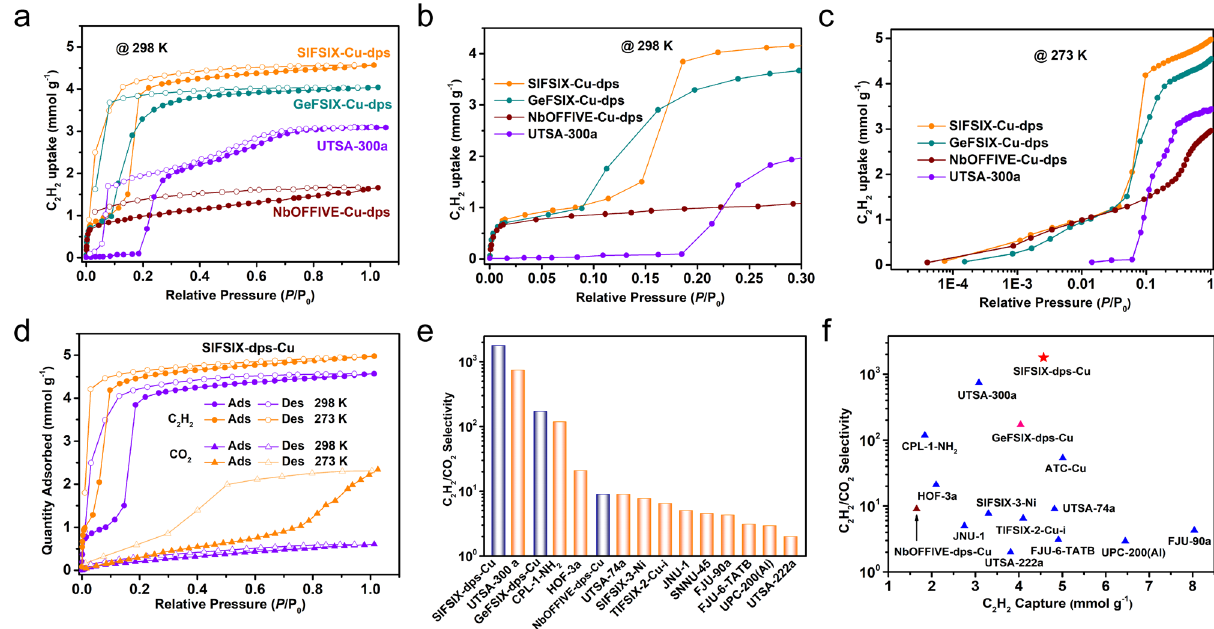
Fig. 2 C 2 H 2 and CO 2 sorption in four isoreticular MOFs. The C 2 H 2 sorption isotherms at a 0 – 1.0 bar and b 0 – 0.3 bar under 298 K. c The C 2 H 2 sorption isotherms at logarithmic 0.01 – 1.0 bar of SIFSIX-dps-Cu, GeFSIX-dps-Cu, NbOFFIVE-dps-Cu, and UTSA-300a at 273 K. d the C 2 H 2 and CO 2 adsorption isotherms of SIFSIX-dps-Cu at 273 and 298 K. e comparison of IAST selectivity of representative MOFs for 50/50 C 2 H 2 /CO 2 . f Comparison about C 2 H 2 / CO 2 selectivity and C 2 H 2 capacity of representative MOFs at 298 K and 1